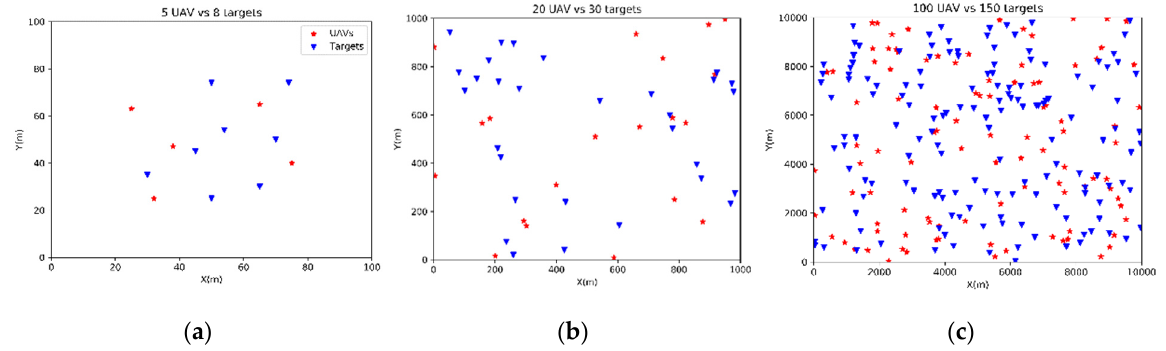
Figure 15. Initial positions of UAV swarm and targets. ( a ) Scenario 1: 5 UAVs and 8 targets were randomly distributed in a space of 100 × 100 m. ( b ) Scenario 2: 20 UAVs and 30 targets were randomly distributed in a space of 1000 × 1000 m. ( c ) Scenario 3: 100 UAVs and 150 targets were randomly distributed in a space of 10,000 × 10,000 m. The parameters of the WPA for different scenarios were set as shown in Table 2. Table 2. Parameters of WPA in three scenarios.